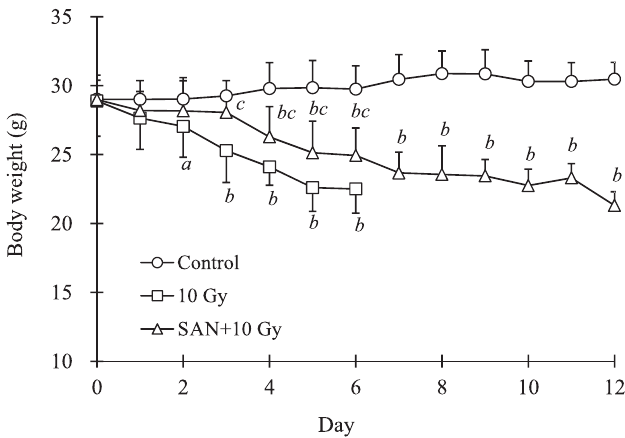
FIGURE 1 - The body weight of mice during the experiment (n=10). a P<0.05 and b P<0.01, compared with control group; c P<0.01 compared with 10 Gy group.